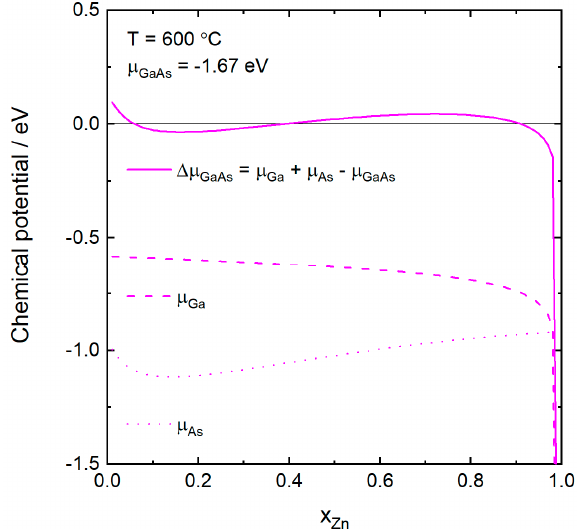
Figure 5. The chemical potentials of As, Ga, and the chemical potential di ff erence for GaAs, ∆ µ GaAs , as a function of the atomic fraction of Zn in the catalyst particle at 600 °C. The chemical potential of GaAs, which is composition independent, is at this temperature − 1.67 eV. Only when ∆ µ GaAs > 0 can GaAs grow, and this occurs for x Zn ≤ 0.05 and 0.39 ≤ x Zn ≤ 0.90. We have also investigated how the p-doping concentration varies with the As concentration in the catalyst particle. We set x Zn = 0.20, x Ga = 0.30, and x As + x Au = 0.50 and varied x As from 0.001 to